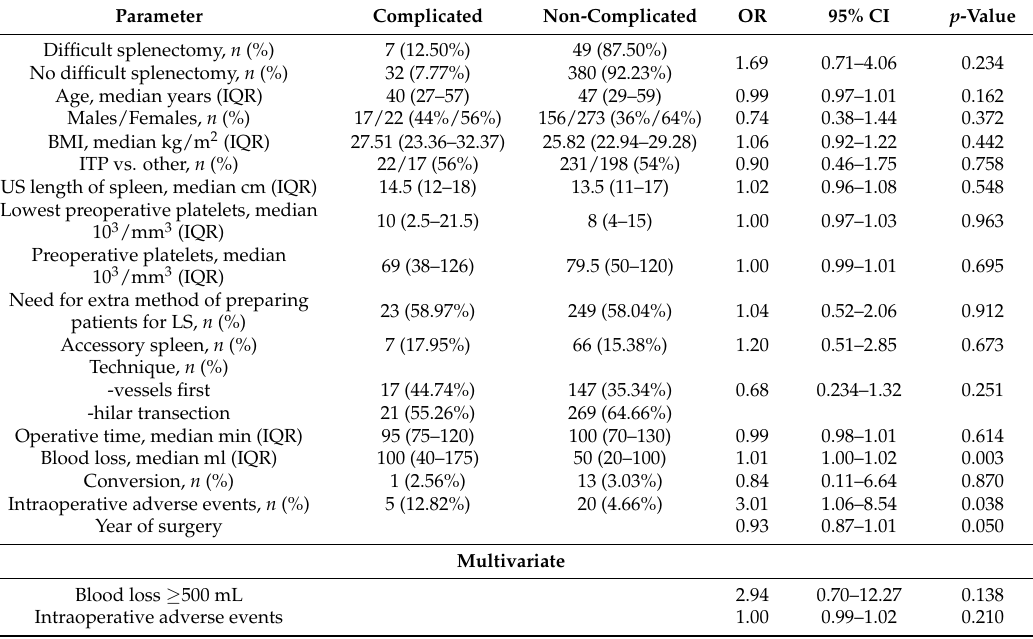
Table 6. Risk factors for perioperative